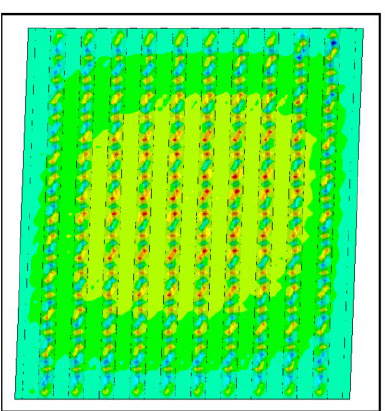
Figure 15. Local buckling.